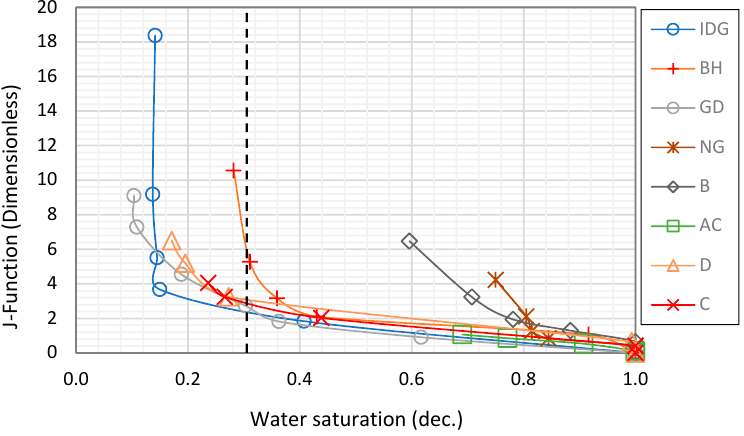
Figure 4. Power-law relationship between electrical resistivity and water saturation in a foamed gas–water system.